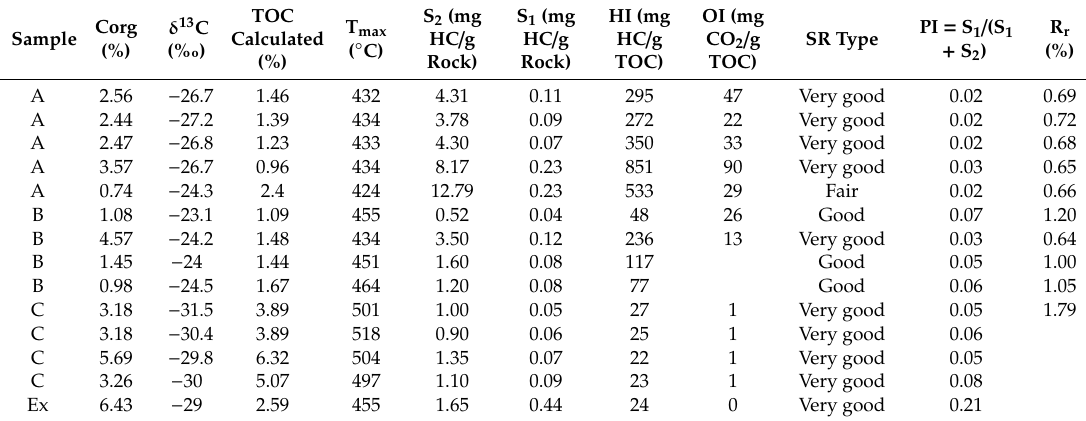
Table 1. Geochemical parameters of the studied shales. Source rock (SR) classification based on measured total organic carbon (TOC) calculation values according to Reference [23]. HI—hydrogen